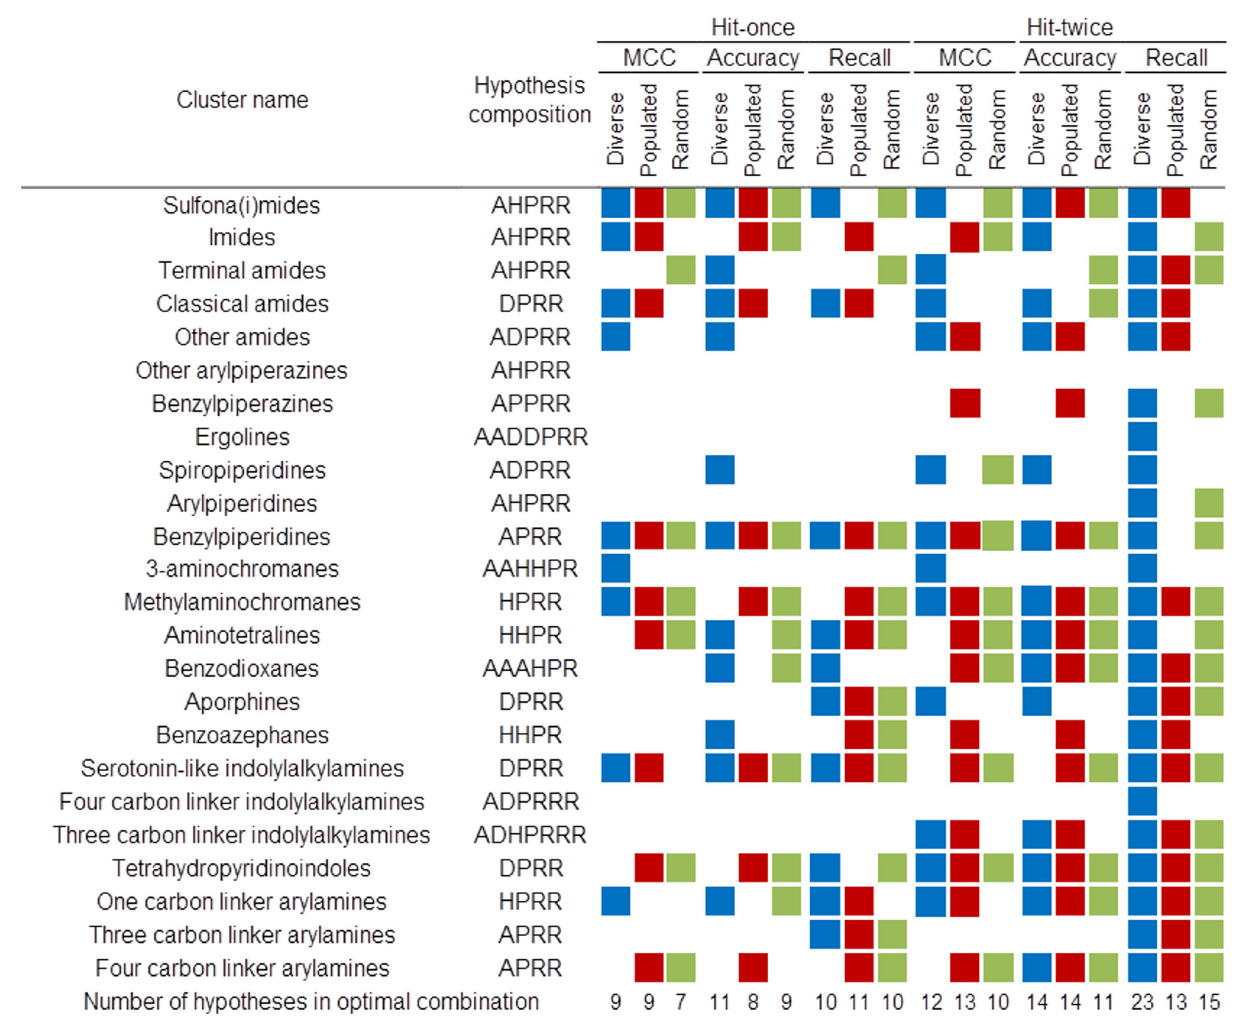
Figure 5. A composition of each top-ranked linear combination obtained using the manual clustering procedure. Each filled square denotes presence of a hypothesis developed on a particular cluster in the optimal combination for appropriate conditions. Colors code the type of the test set: blue – diverse, red – populated, and green – random. The last row contains the total number of hypotheses forming a respective top-ranked combination. The values of the optimized statistical parameters for manual clustering are shown in Figure 4, and those for accuracy and recall are shown in Figures S1 and S2, respectively. The exemplary linear combination (manual/random/hit-once; 7 hypotheses long) is shown in Figure